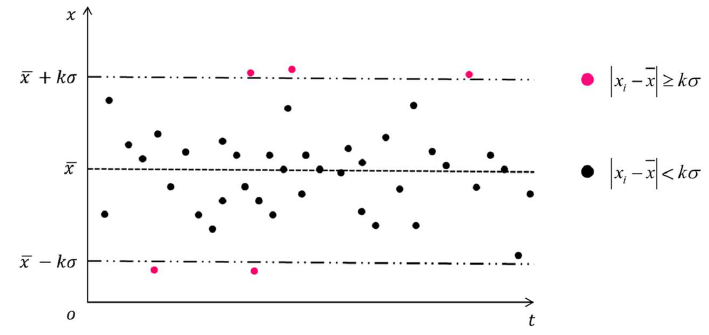
Figure 6. Sketch map of the “ k σ ” rule for detecting